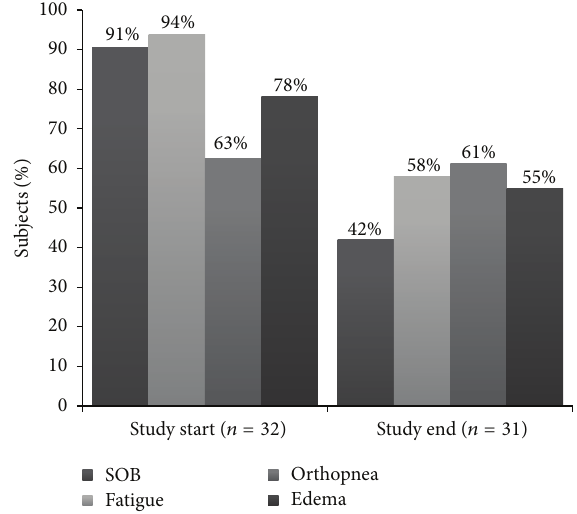
Figure 2: Percent of patients reporting individual symptoms com- mon in HF at the beginning and end of the study. SOB= shortness of breath. Study start was 1.0 days (median) after admission; study end was 1.0 days (median) before